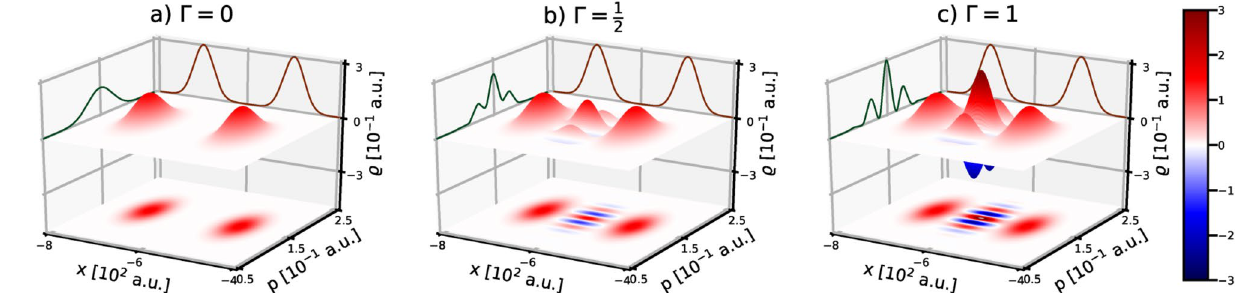
Figure 1. Influence of the quality parameter Ŵ on the Wigner form of the initial DSC-state with ϑ = 0 . Marginal distributions (not to scale with WDF units) with respect to position and momentum are shown on the sidewalls with brown and green solid lines